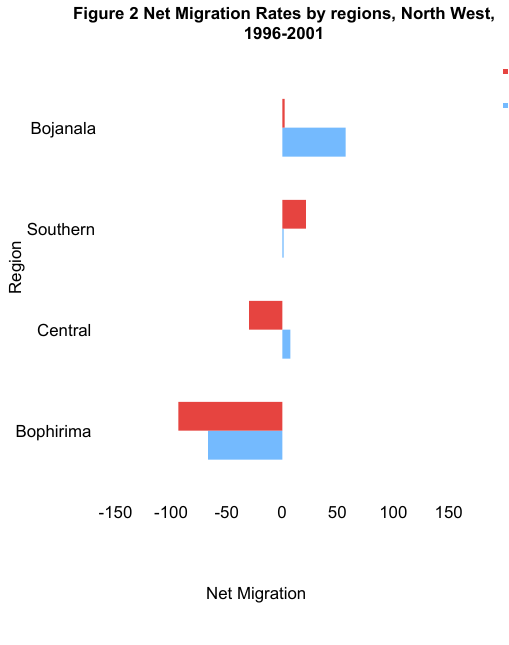
Figure 2 Net Migration Rates by regions, North West,